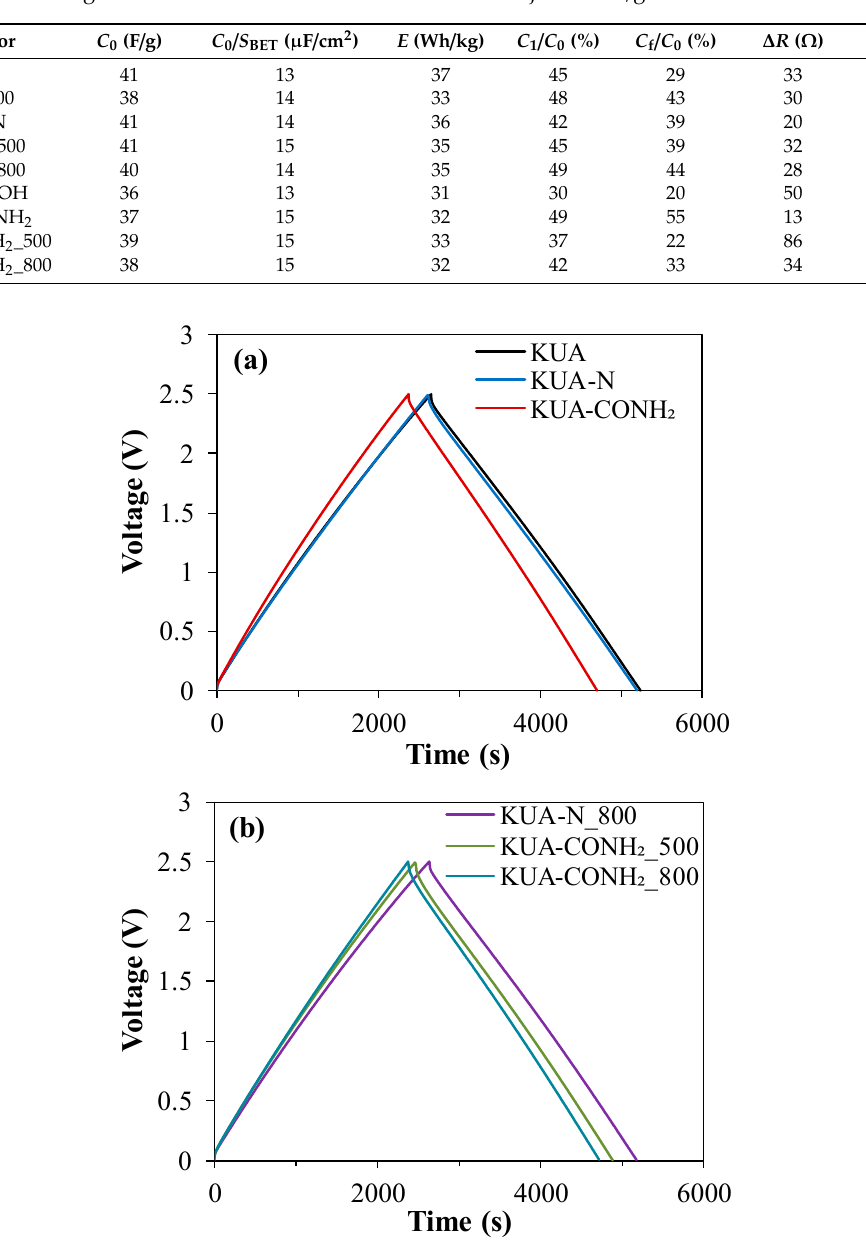
Table 4. Gravimetric capacitance, surface capacitance, energy density, retention of capacitance at 1000